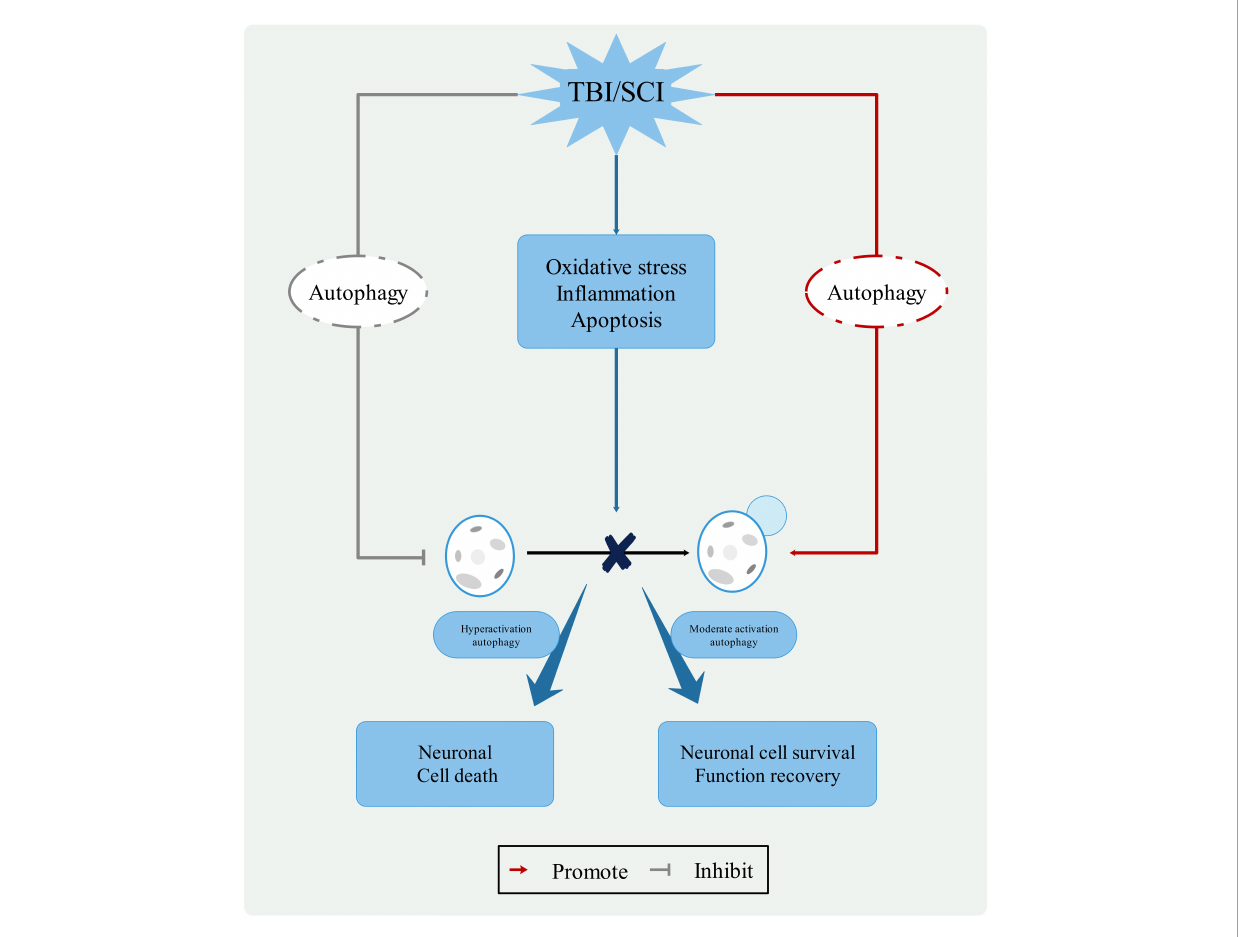
FIGURE3 The role of autophagy in CNS trauma. When the CNS is damaged, changes in the pathophysiological processes, such as oxidative stress, inflammatory response, and apoptosis, leading to changes in the lysosomal membrane and blockage of the autophagy process. Moderate activation autophagy can protect neuronal cell and function recovery, hyperactivation autophagy causes neuronal cell death. Therefore, autophagy pathway represents a potential clinical therapeutic value for treatment of CNS